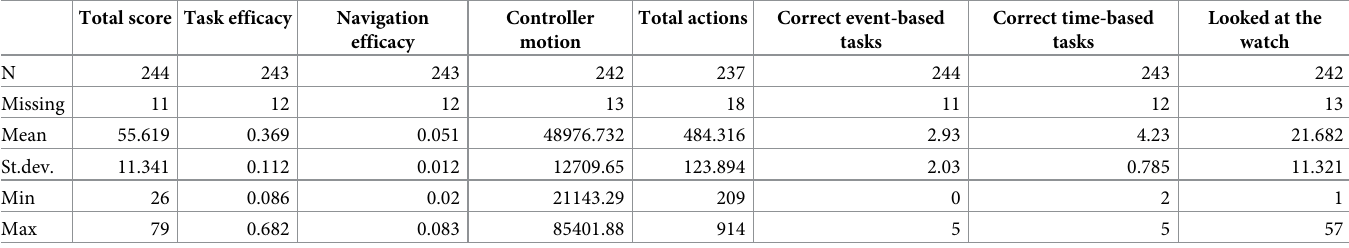
Table 2. Performance in